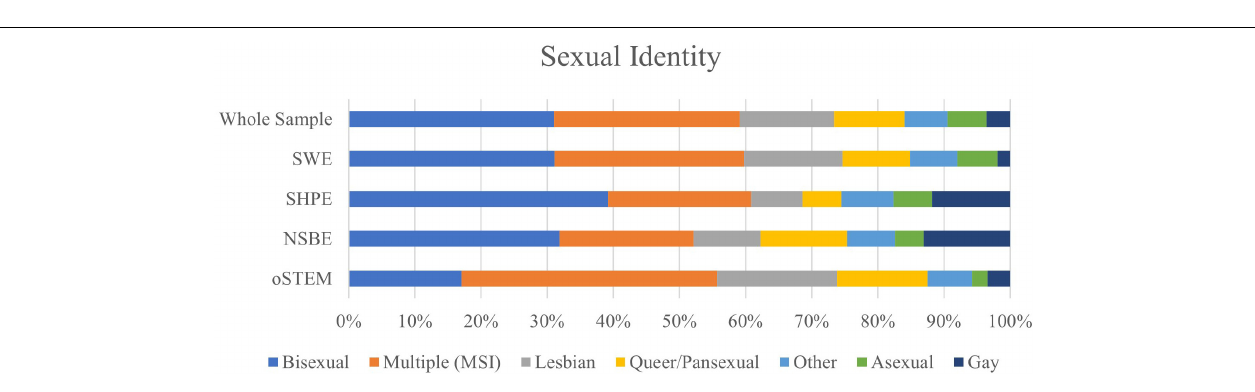
FIGURE 2 | Sexual identity of sample, SWE, SHPE, NSBE, and oSTEM